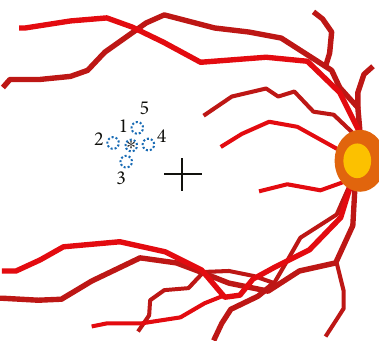
Figure 2: A depiction showing the location of laser spots. Initially, a laser spot was applied to the leakage point (asterisk). Next, several additional laser spots were applied around the leakage point. The distance between the spots was generally set as 0.5 to 1.0 spot diameter (100 to 200 μ m). Blue dotted circles indicate the location of laser spots. The numbers (1 to 5) indicate the order of laser